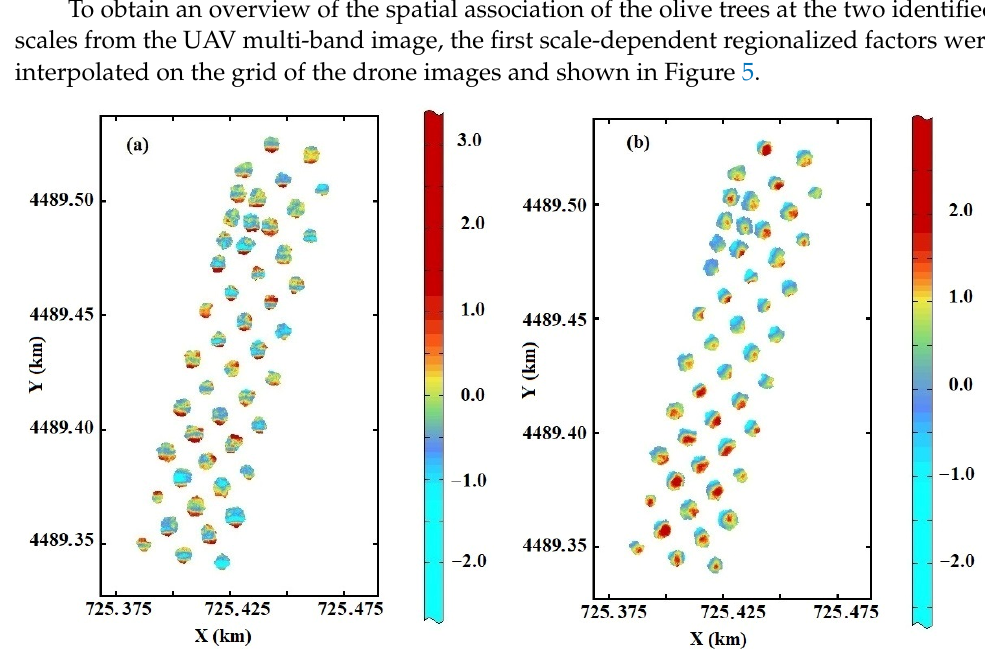
Figure 5. Maps of the first regionalized factor at short range ( a ) and at long range ( b ). The color legend uses 10 isofrequency classes.